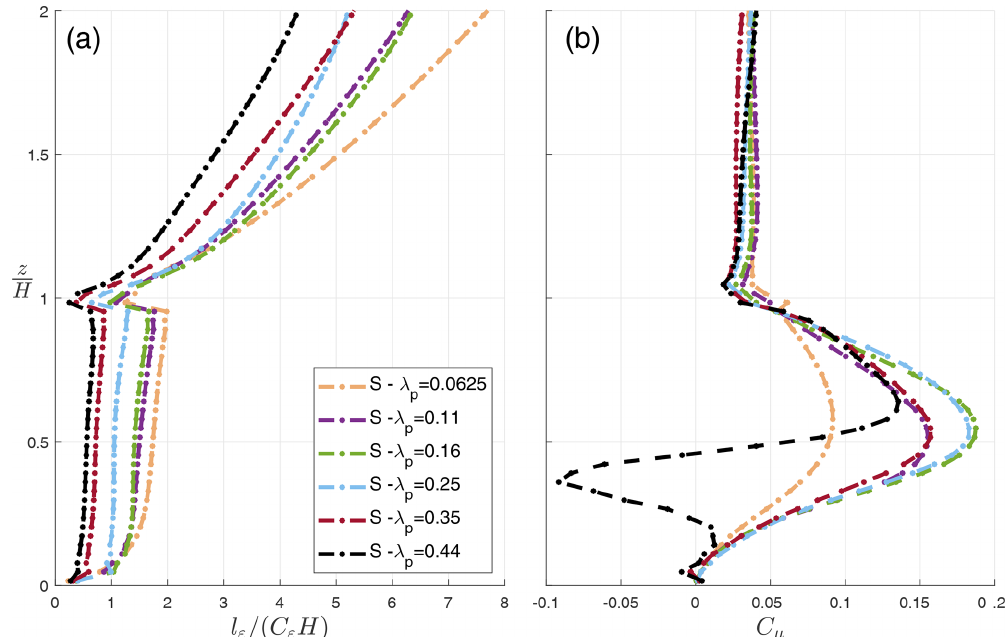
Figure 10. (a) Vertical profiles of dissipation length scale ( l ε /C ε ) for staggered (S) urban configuration and varying urban packing density ( λ p ). l ε /C ε is calculated based on dissipation at the subgrid scale (Maronga et al., 2015) and Eq. (6). (b) Vertical profiles of model constant for turbulent viscosity ( C µ ) calculated based on Eq.